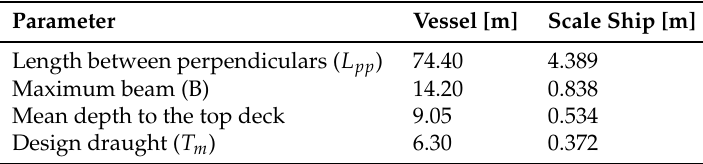
Table 1. Parameters and dimensions of the vessel and the scale